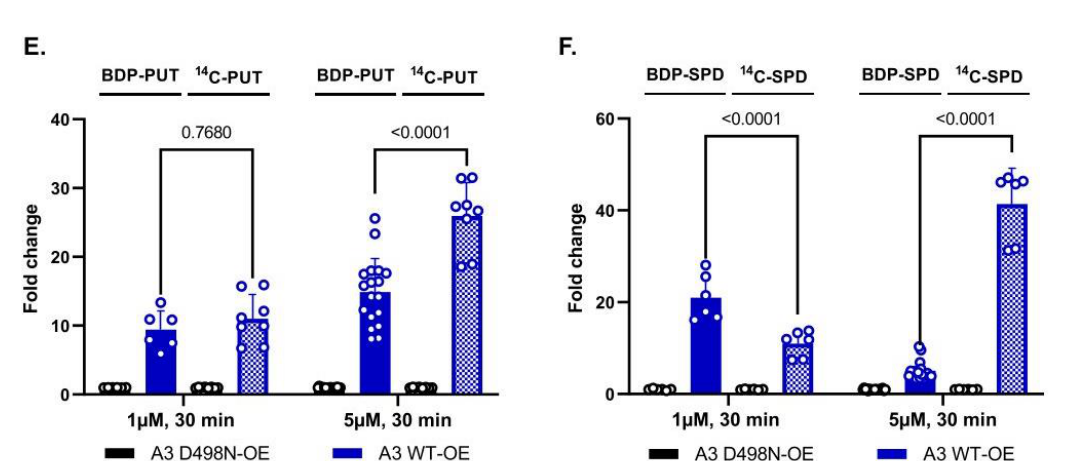
Figure 3. Time- and dose-dependency of BODIPY-PUT and BODIPY-SPD uptake in ATP13A3-expressing HMEC-1 cell models. ( A , C ). Time dependent BODIPY-polyamine uptake in HMEC-1 cells incubated with 5 µ M BODIPY-PUT ( A ) or BODIPY-SPD ( C ). The mean fluorescence intensity (MFI) of 10,000 events was recorded using a BD Canto II HTS flow cytometer. Graphs represent the fold change between the MFI recorded in A3 WT-OE versus A3 D498N-OE cells, normalized to the 0 h incubation time in A3 D498N-OE cells. (N = 3 to 9, with technical duplicates, two-way ANOVA with Sidak’s multiple comparisons test). ( B , D ). Dose–response of BODIPY-PUT ( B ) or BODIPY-SPD ( D ) uptake in HMEC-1 cells at 30 min. The MFI of 10,000 events was recorded using a BD Canto II HTS flow cytometer. Graphs represent the fold change difference between the MFI recorded in A3 WT-OE and A3 D498N-OE cells, normalized to the highest concentration of BODIPY- polyamine (i.e., 100 µ M) in A3 D498N-OE cells ( N = 3 to 9, with technical duplicates, two-way ANOVA with Sidak’s multiple comparison test; ns: not significant, *: p < 0.1; **: p < 0.01; ***: p < 0.001; ****: p < 0.0001). ( E , F ). Comparison of the uptake of 1 and 5 µ M BODIPY-conjugated (BDP-PUT and BDP-SPD) versus radiolabeled putrescine and spermidine ( 14 C-PUT and 14 C-SPD) in HMEC-1 A3 WT-OE and D498N-OE cells for 30 min (N = 3 to 9, technical duplicates, two-way ANOVA with Tukey’s multiple comparisons